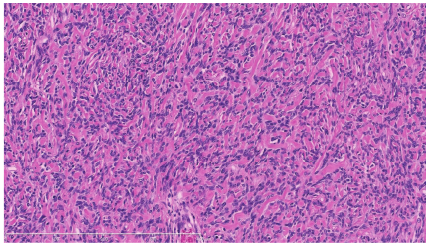
Figure 5: Tumour showing areas of hypocellularity and dense col- lagenous stroma. × 200 magnification.